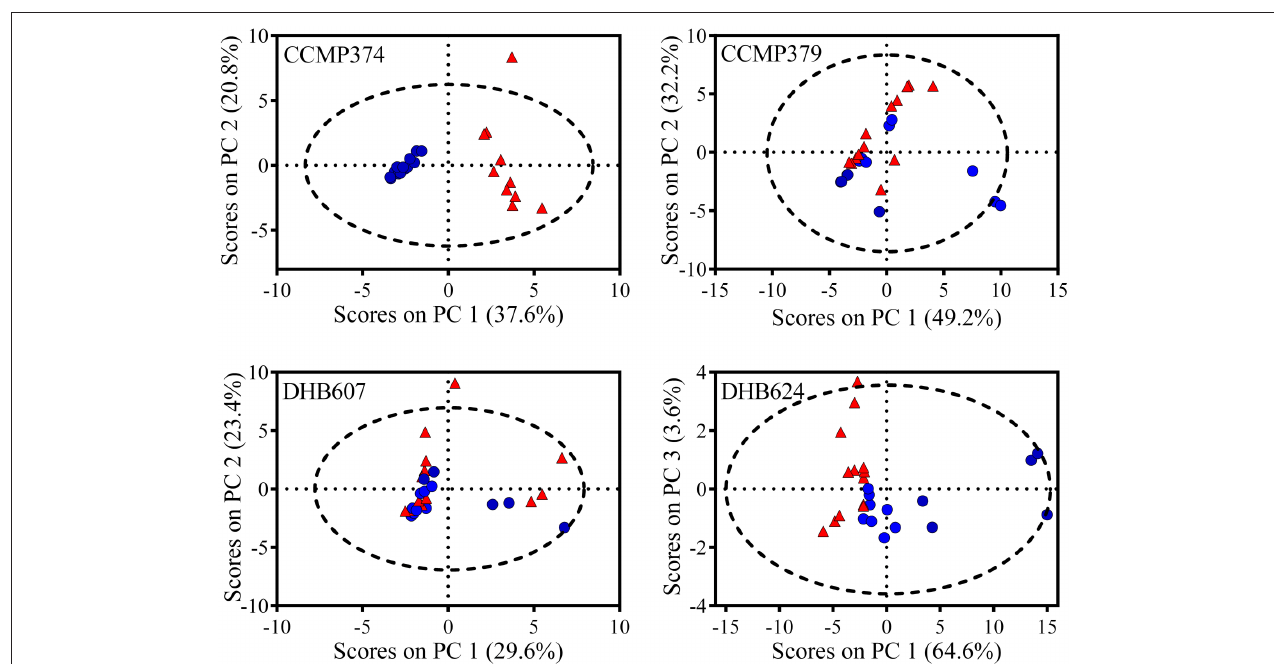
FIGURE 2 | PCA Scores plot comparing exometabolomes of Emiliania huxleyi grazed by Oxyrrhis marina (red triangles) and E. huxleyi only (blue circles) control cultures ( n = 10 –13, depending on E. huxleyi strain). Four different strains (CCMP374, CCMP379, DHB607, and DHB624) of E. huxleyi were grazed for 48h before extraction of exometabolomes. Dashed line represents 95% confidence interval.